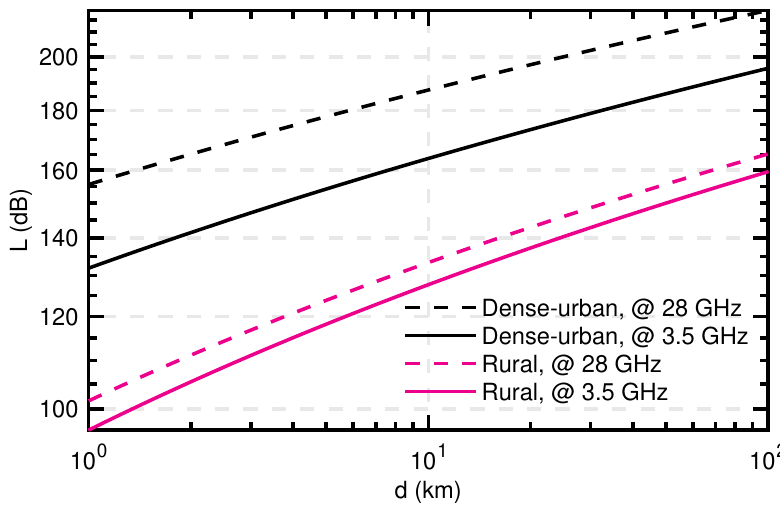
Figure 13. Free-space path loss for different